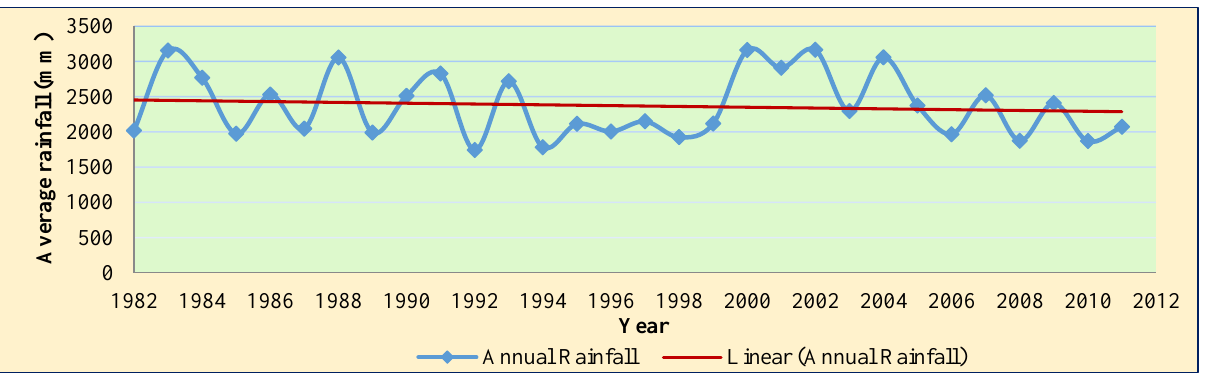
Figure 3. Annual average rainfall scenario in Lawachara National Park (1982 to 2011).